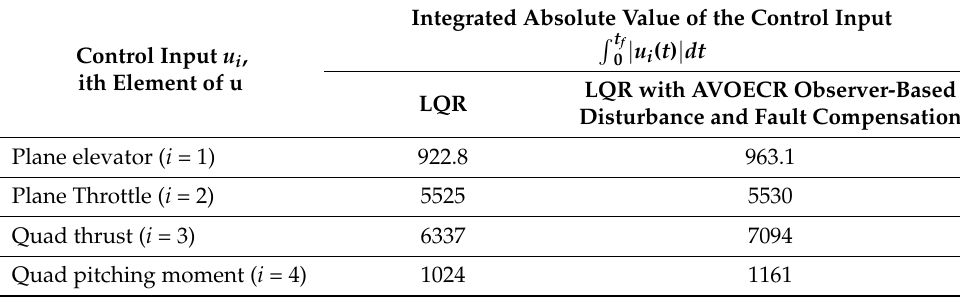
Table 7. Control effort comparison in the wind and actuator fault rejection